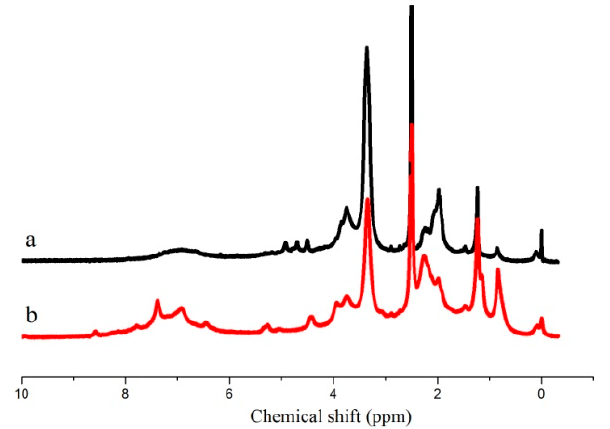
Figure 8. 1 H NMR spectra of WSAL ( a ) and D-WSAL ( b ) prepared under the optimum demethylation condition: the demethylation process was carried out with 12 molar ratio of ICH to lignin, prepared at 145 °C with 4 mL DMF for 3 h under nitrogen atmosphere. Table 6. Relative contents of the protons calculated from 1 H NMR spectra.